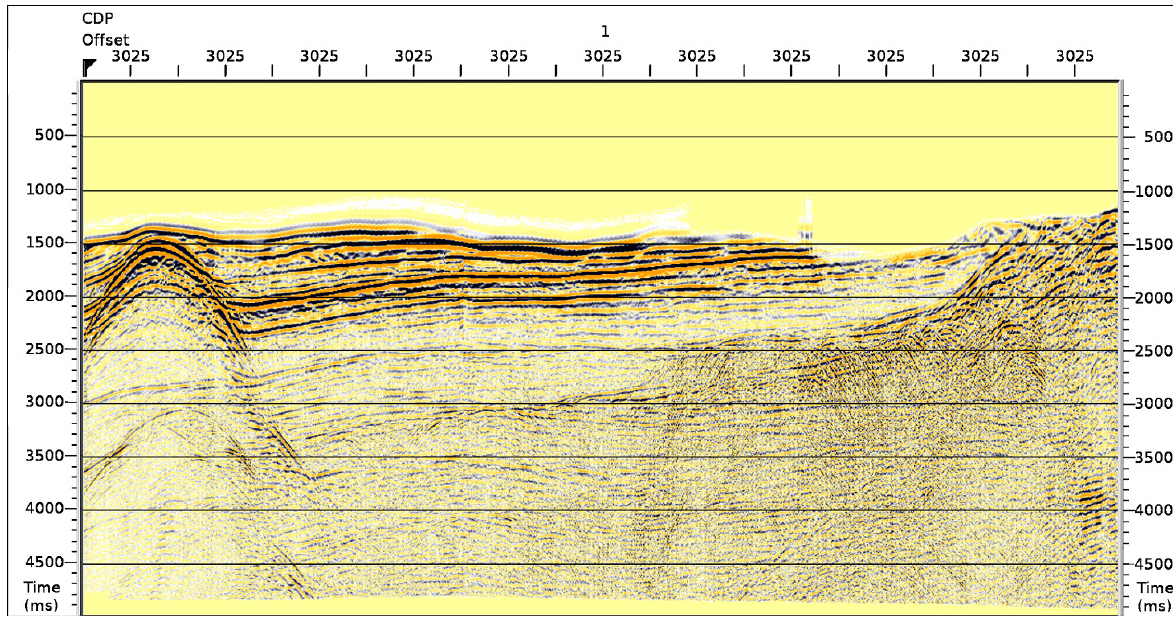
Figure 10. Stacked seismic section where the NMO velocity was estimated using the method of Castle (1994). Note a higher resolution and reflector continuity between 1500 and 2000